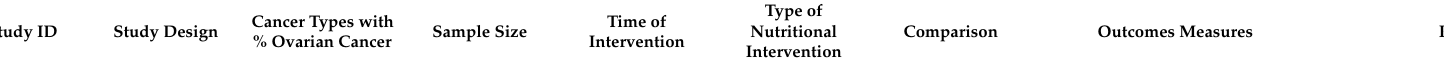
Table 2. Characteristics of included